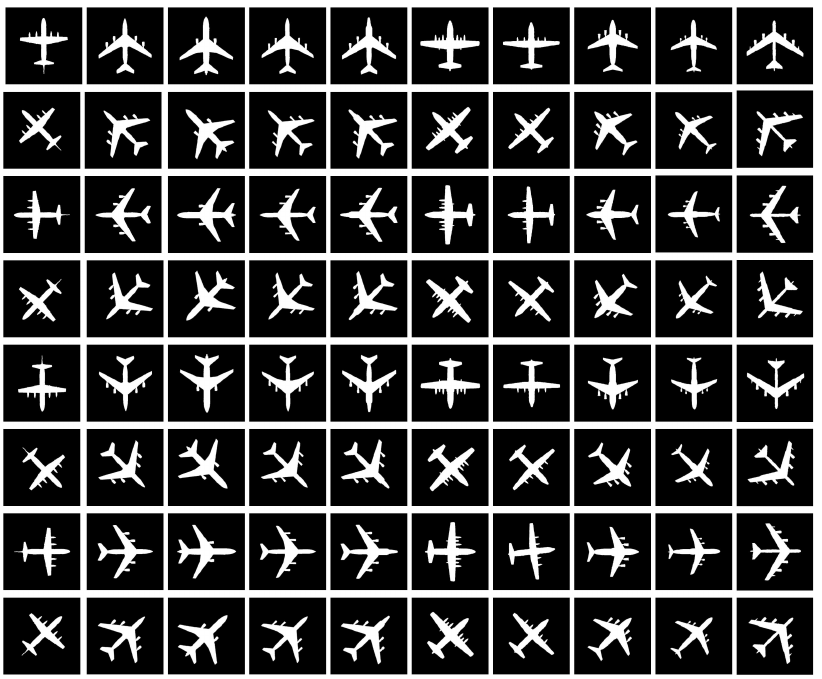
Figure 4. Original shape templates of ten types of aircrafts in different